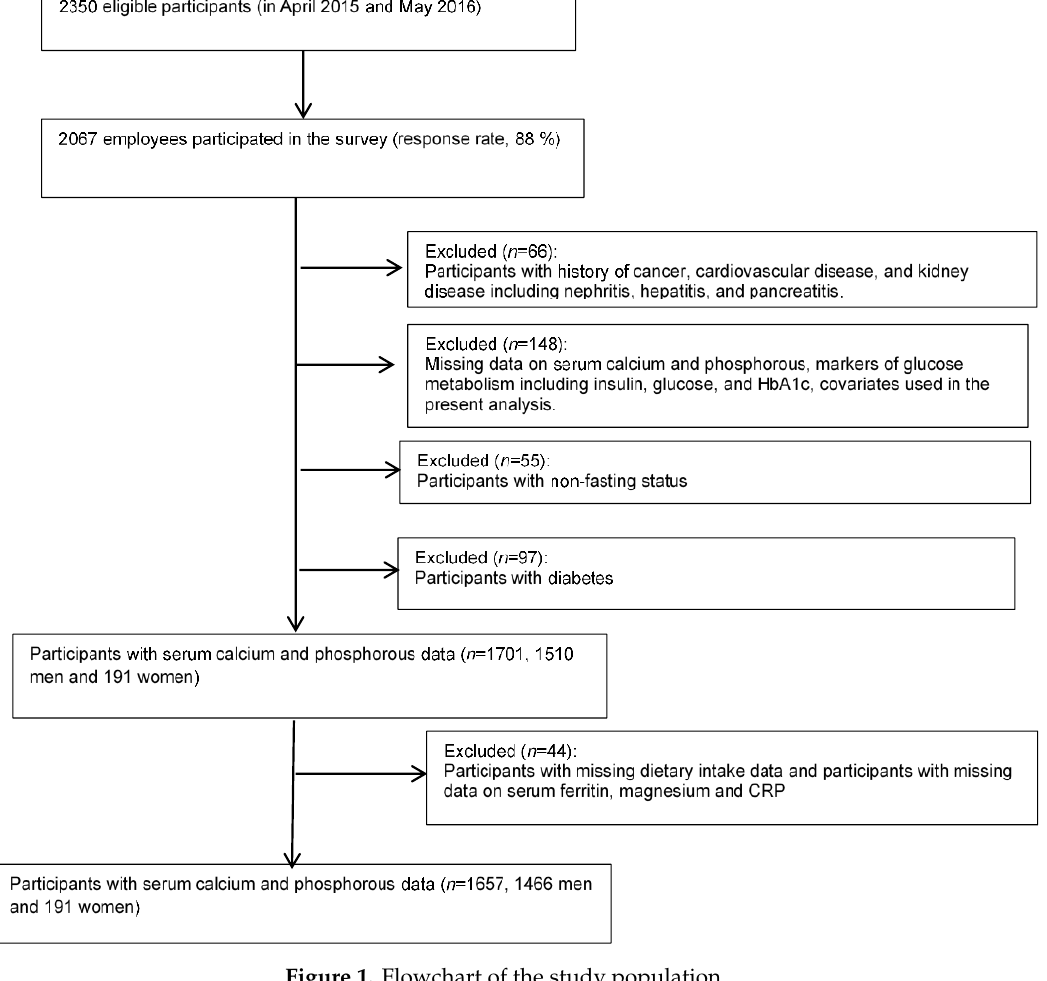
Figure 1. Flowchart of the study population.